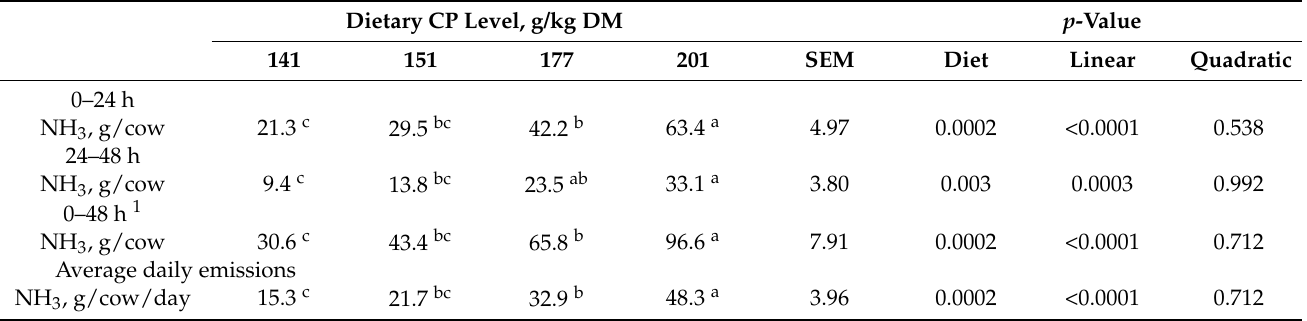
Table 3. Effect of dietary CP level on NH 3 emissions from slurry from lactating cows by measurement time interval. Dietary CP Level, g/kg DM p